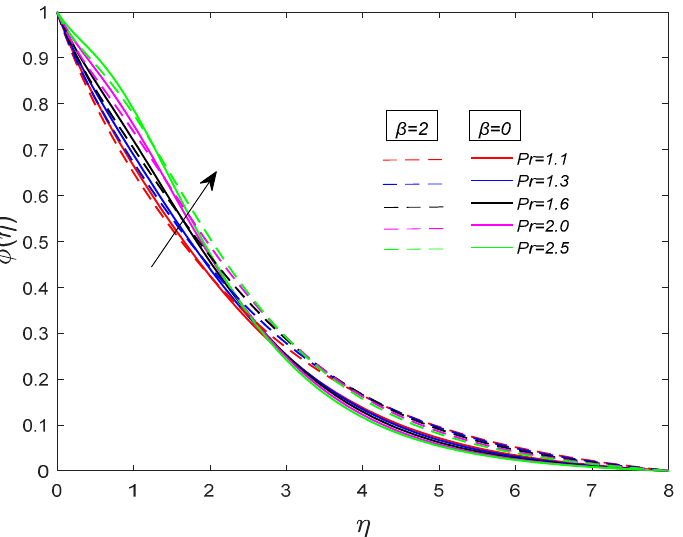
Figure 13. Effect of the Prandtl number (Pr) on concentration profiles with Ec = M = Kr = Sc = 0.5, Sr = 1.5.